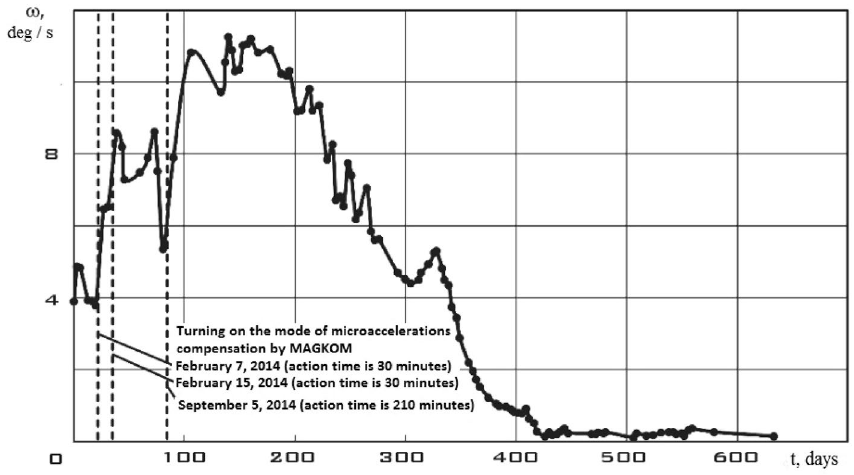
Figure 2. There is dynamics of changes in the angular velocity modulus of the small spacecraft prototype "Aist" rotation (dotted lines indicate attempts to reduce the angular velocity by magnetic actuators) (cited in 5